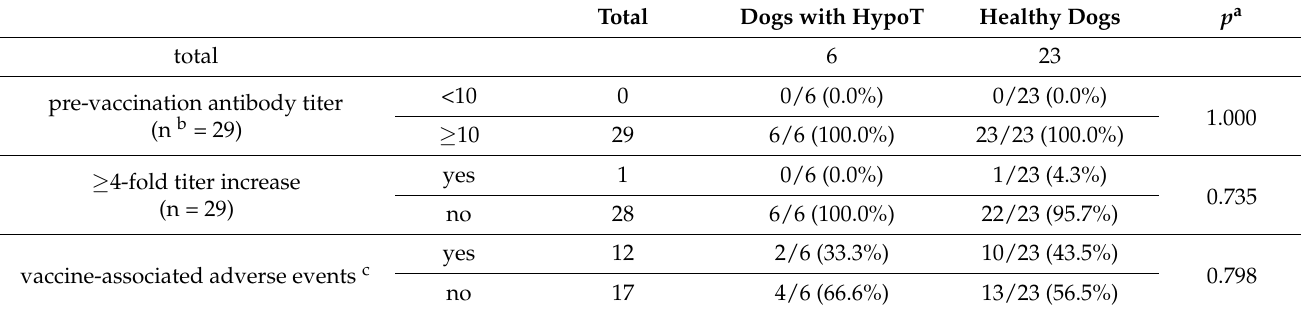
Table 2. Comparison of the humoral immune response of dogs with hypothyroidism (HypoT) treated with thyroxine and healthy dogs after modified live virus vaccination against canine parvovirus using Bayesian logistic regression. Total Dogs with HypoT Healthy Dogs p a total 6 23